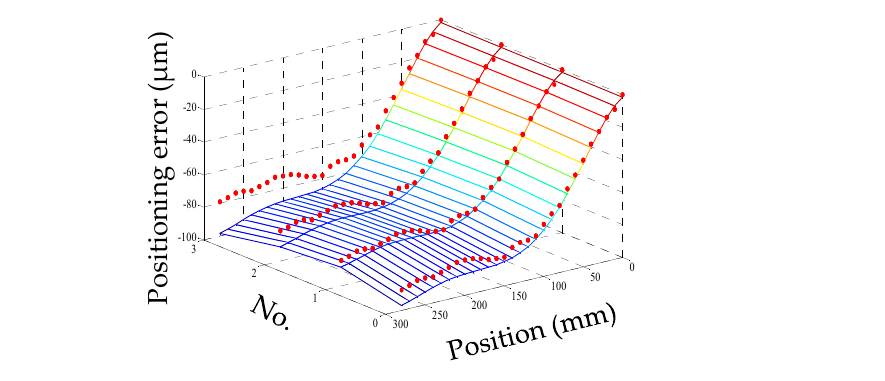
Figure 18. The prediction results of the MLR model (measured positioning error marked with dots) in experiment II.